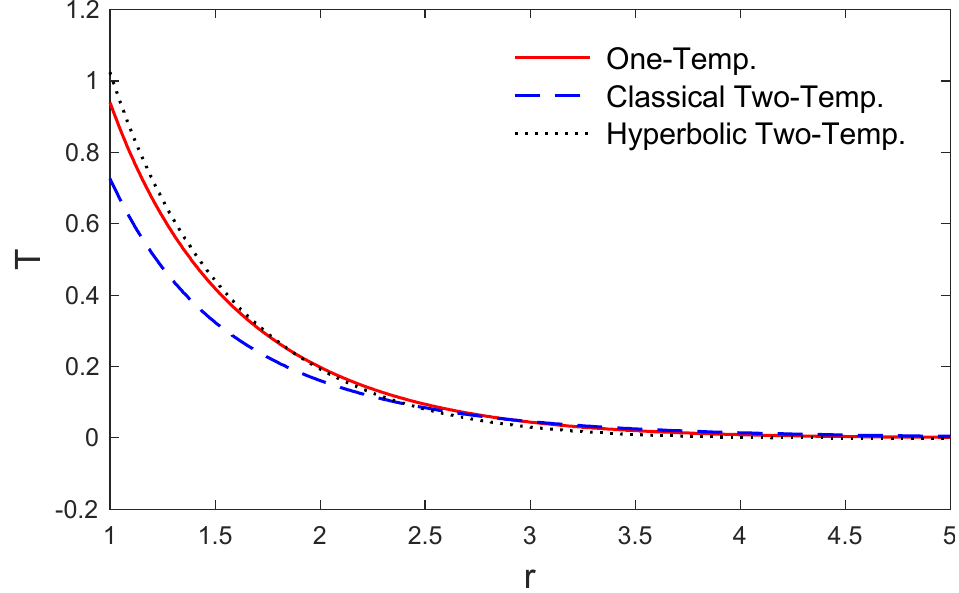
Figure 2. The variation of thermodynamic temperature with distance for different models.